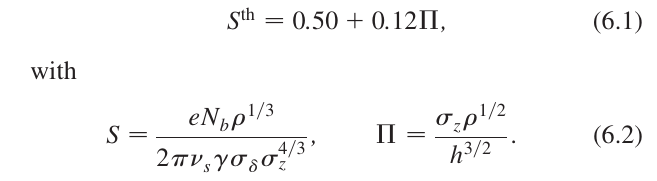
FIG. 14. The momentum acceptance, (cid:8) chine errors. This function is used in finding the Touschek